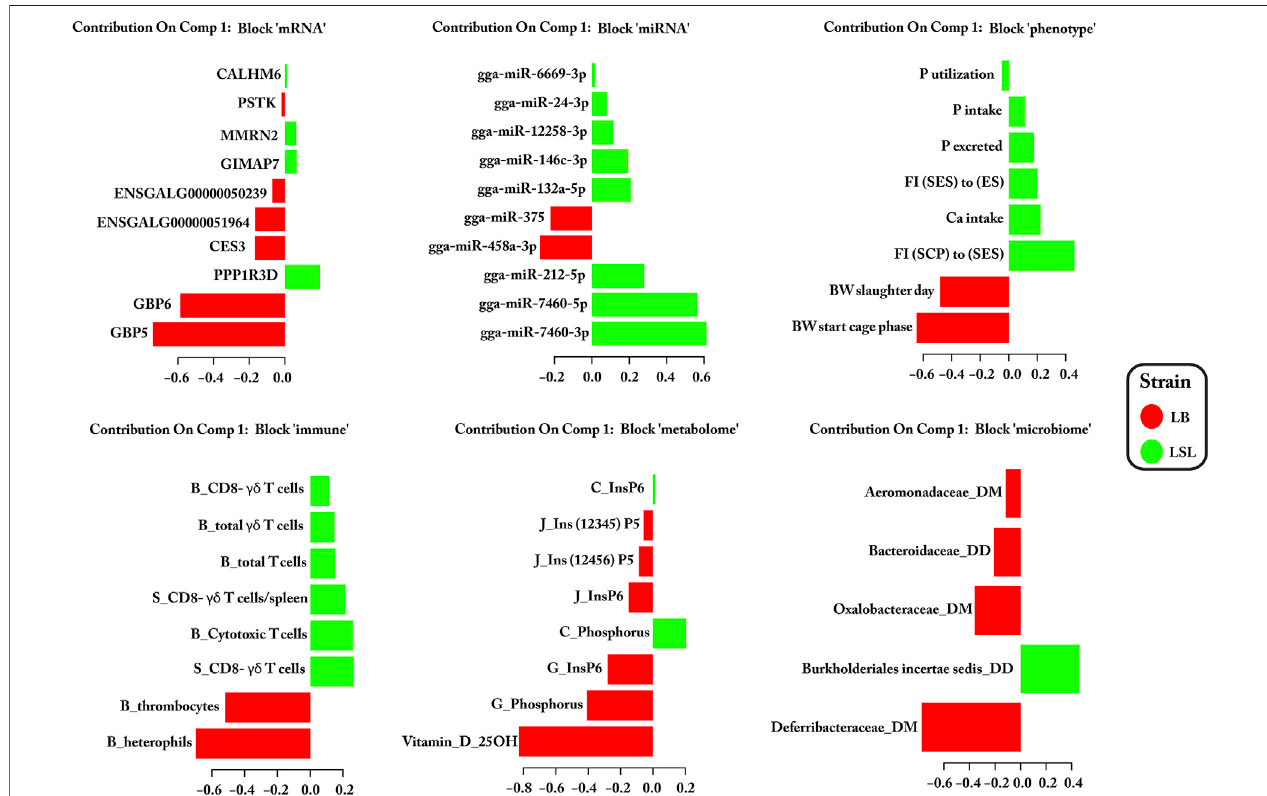
FIGURE 3 | Signi fi cant biomarker loading weights for blocks of miRNAs, mRNAs, phenotypic traits, immune cells, metabolites, and microbes discriminating between LB and LSL over component 1. Barplot names correspond to the feature selected on each block: mRNA, miRNA, phenotype, immune traits [B (blood) or S (spleen)meanstheoriginalorganfromwhichtheseimmunecellsoriginate],metabolome[C(crop) orJ(jejunum)orG(gizzard)meanstheoriginalorganfromwhichthese metabolites originate], and microbiota (DD or DM means duodenum digesta and mucosa). The length of the bar represented the signi fi cance (loading weights) of the selected features, while the color is related to the strain in which the speci fi c feature is most abundant.